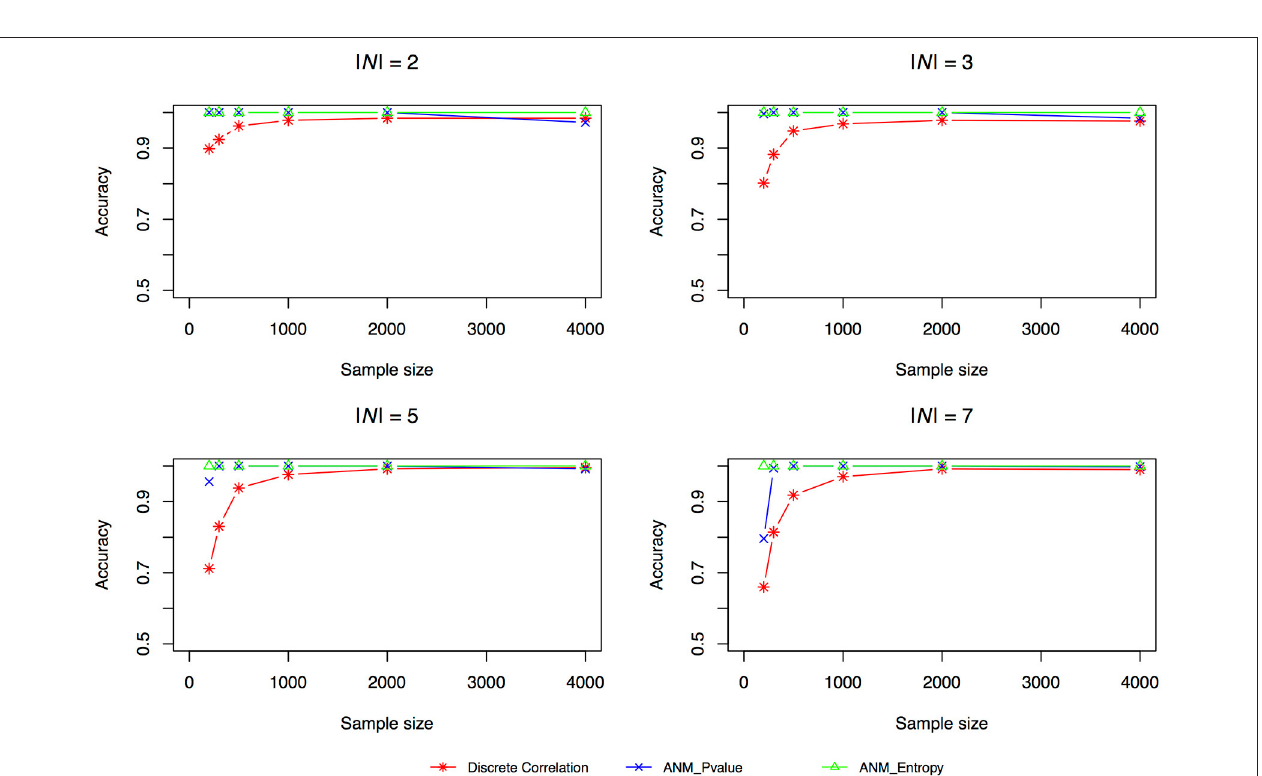
3. Simulation scenario 3, |N| =